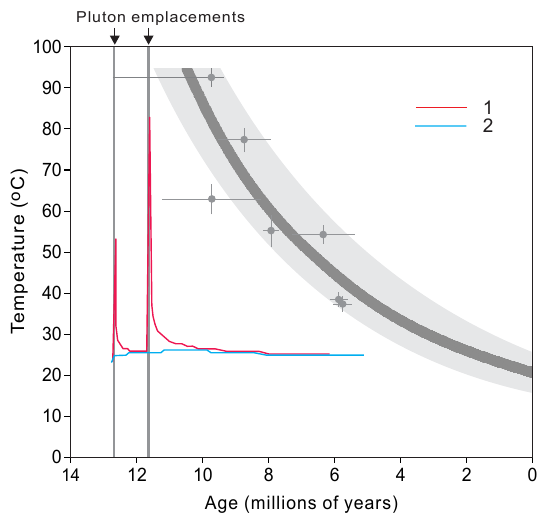
Figure A4. Sensitivity simulations illustrating the effect of the in- trusion advection option on magma emplacement. Temperature at the reference point ( z = 300m): (1) the intrusion advection is en- abled; (2) the intrusion advection is disabled. There was no water convection.